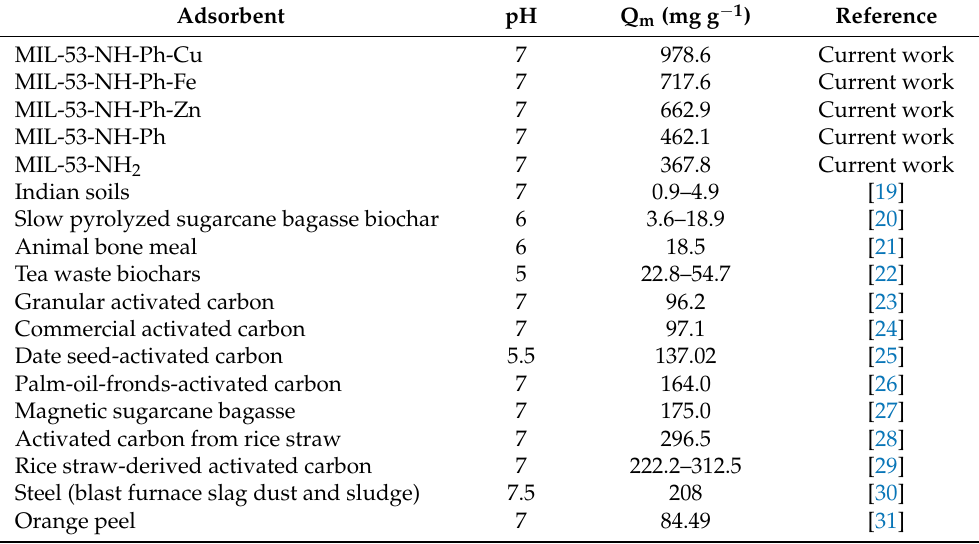
Table 5. Adsorption capacity for carbofuran onto different adsorbents reported in this study and the literature.